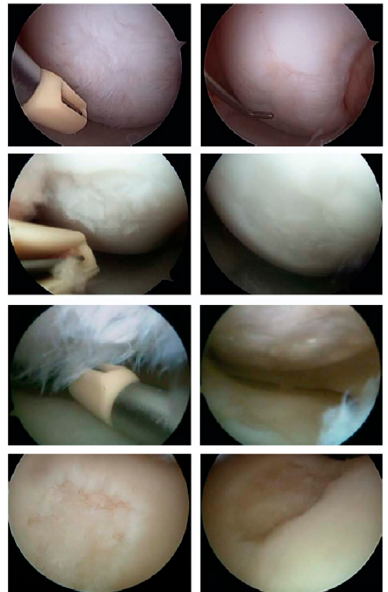
Figure 2. Pre-treatment ( Left ) and post-treatment ( Right ) images of human knee articular cartilage surfaces. The surgical device shown is a physiochemical scalpel designed to repair damaged biologic tissue surfaces by mimicking the respiratory burst myeloperoxidase system of azurophilic granules in polymorphonuclear neutrophil granulocytes that deliver protonation potentials during the acute phases of wound healing. Image reproduced with permission from [4].